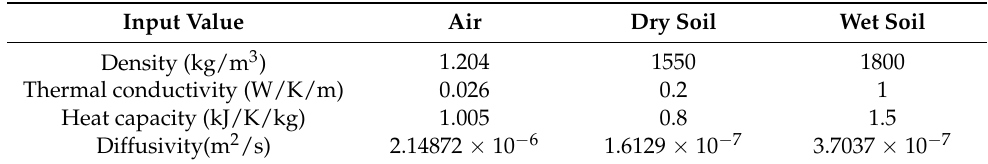
Figure 5. E1 pulse shape used in simulation. Table 4. Input values used in FIM.